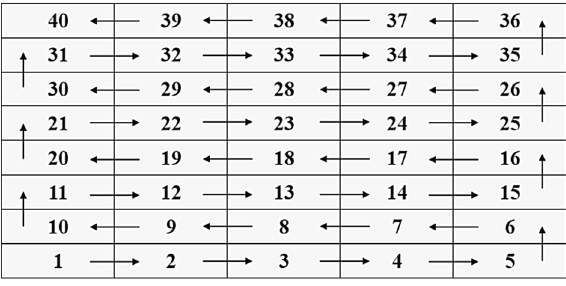
Image processing. Figure 5 vividly shows the specific procedure of image processing. Image processing involves base map splicing and color overlapping. In order to ensure complete and seamless splicing, the images were spliced in the form of an S-shaped route with a horizontal overlapping width of 1/4 and a vertical overlap- ping length of 1/3. In the procedure of color overlapping, corresponding colors fell respectively into seven differ- ent elements, and then these seven different colors were added to the base map according to the RGB values 19,21 . Finally, color-added maps were spliced in the same way as the base maps.